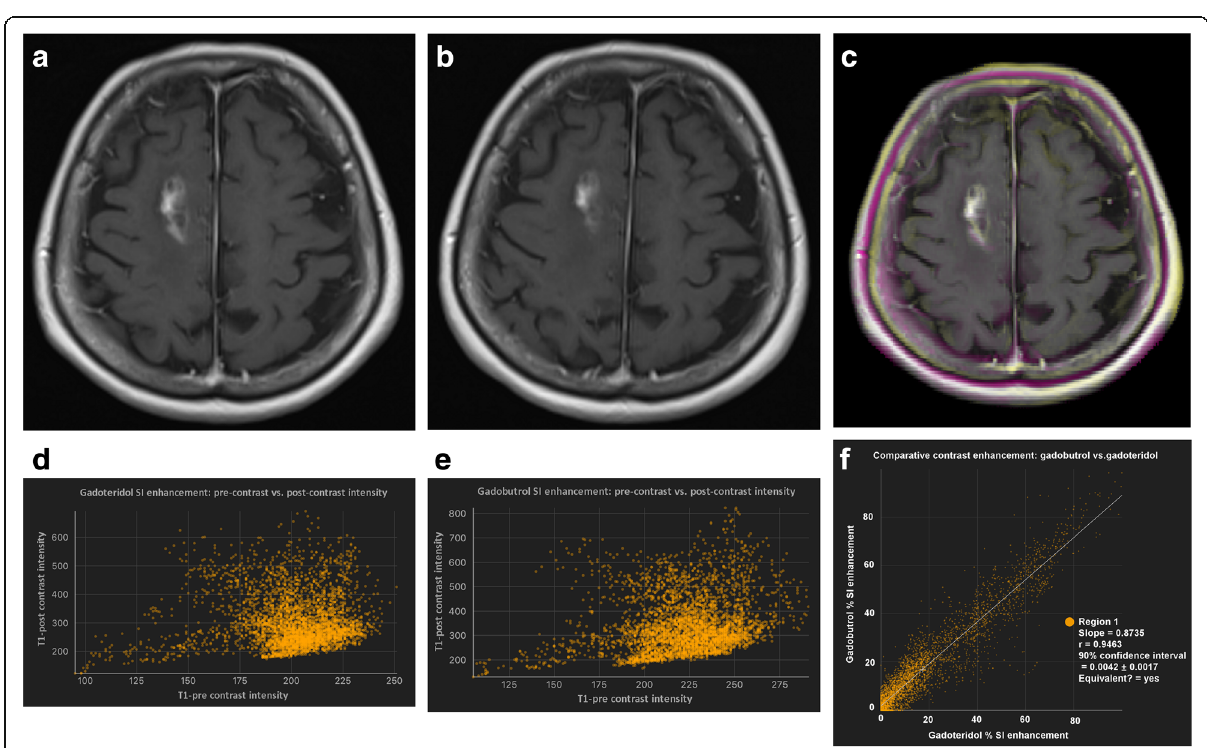
Fig. 9 74-year-old woman with glioblastoma in the right centrum semiovale. Conventional T1-weighted SE contrast-enhanced images for the first exam with gadoteridol ( a ) and the second exam with gadobutrol ( b ) and the QE change map ( c ) where colour indicates regions differing in enhancement between the two exams. Scatter charts (T1-weighted contrast-enhanced versus unenhanced) of enhancing voxel regions of interest reveals the patterns of enhancement for gadoteridol ( d ) and gadobutrol ( e ). The net QE was +711.26 for gadoteridol ( a , d ) and +695.47 for gadobutrol ( b , e ). The gadoteridol minus gadobutrol difference (15.79, 2.22%) was not significant, and the 90% confidence interval for the mean of the differences fell entirely within the equivalence zone indicating equivalence for the two contrast agents, as demonstrated in the comparative scatter chart ( f